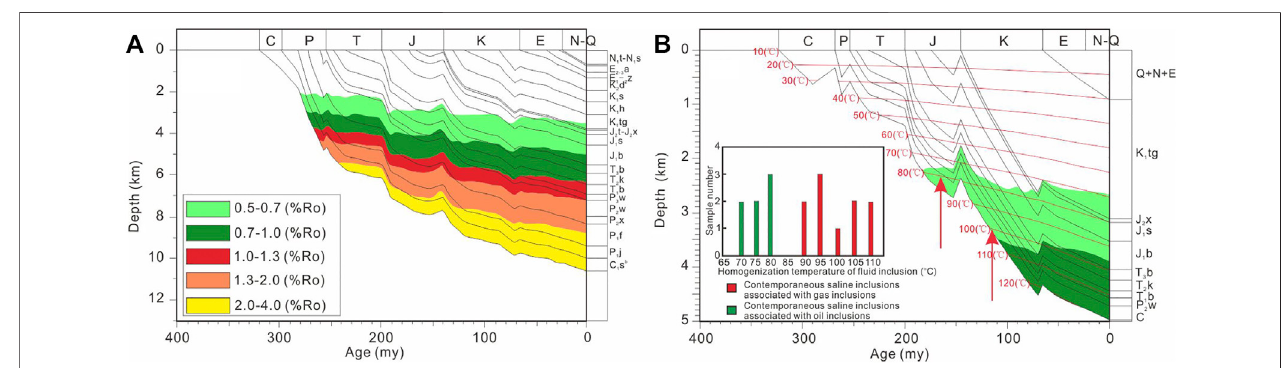
FIGURE 7 | Burial history and geothermal evolution history of (A) virtual well and (B) Well SX16 in the Pengyijingxi Sag.